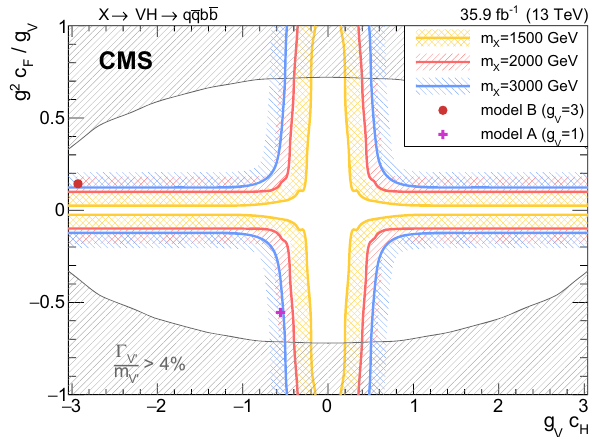
Fig. 7 Observed exclusion in the HVT parameter plane (cid:4) (cid:5) g V c H , g 2 c F / g V for three different resonance masses (1.5, 2.0, and 3.0 TeV). The parameter g V represents the coupling strength of the new interaction, c H the coupling between the HVT bosons and the Higgs boson and longitudinally polarized SM vector bosons, and c F the coupling between the heavy vector bosons and the SM fermions. The benchmark scenarios corresponding to HVT model A and model B are represented by a purple cross and a red point. The gray shaded areas correspond to the region where the resonance natural width is predicted to be larger than the typical experimental resolution (4%) and thus the narrow-width approximation does not